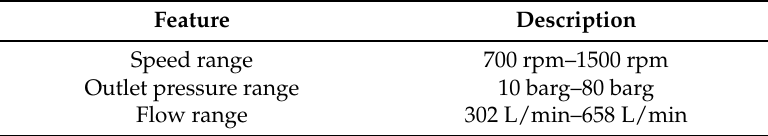
Table 7. Commercial unit: Danfoss APP 38-46 type pump, unit 180B3071 [32].